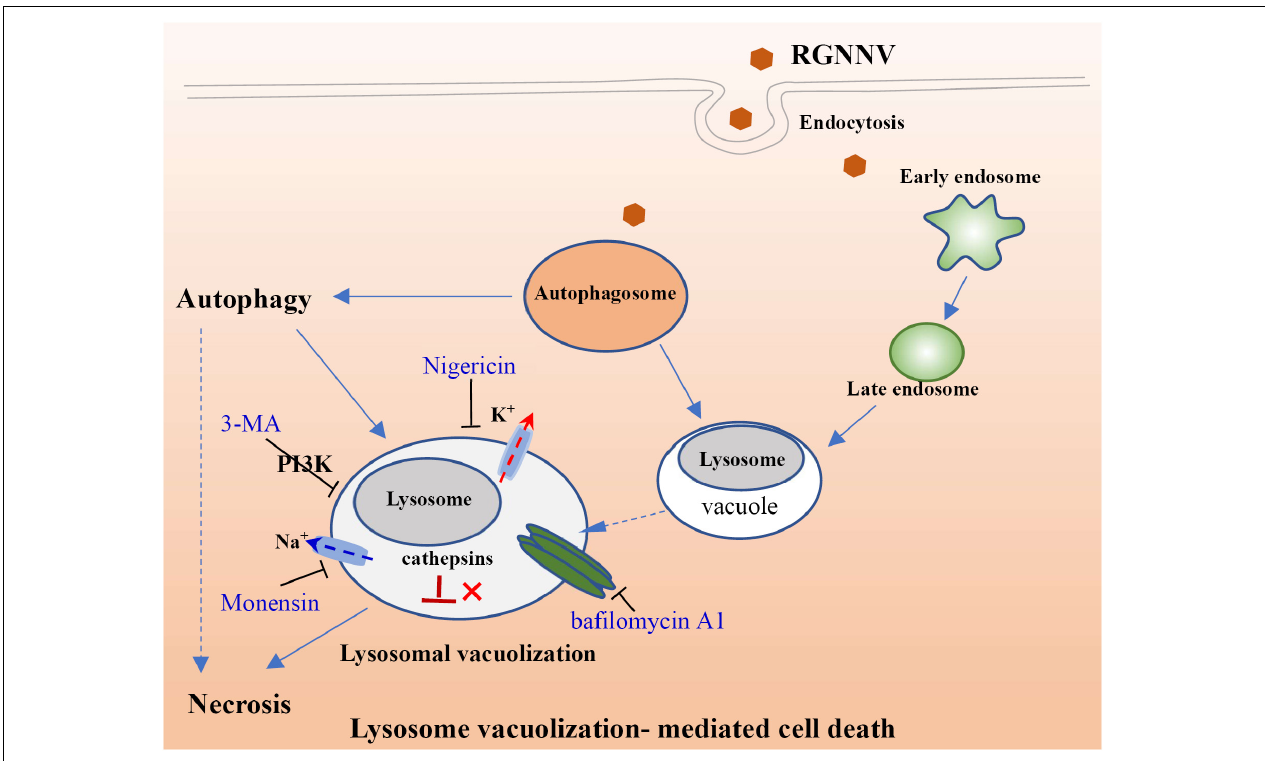
FIGURE 9 | Proposed model of lysosomal vacuolization-mediated cell death during RGNNV infection.